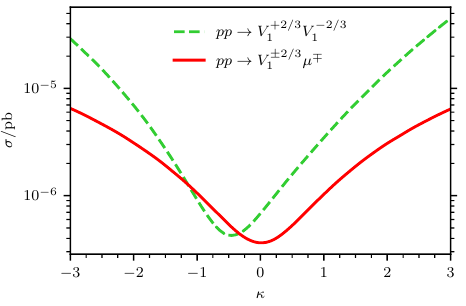
Figure 2 . κ -dependence (2.6) of the single- (red, solid) and pair production cross section (green, √ s = 14 TeV and M V dashed) for V 1 . We fix = 3 TeV . For the single production cross section 1